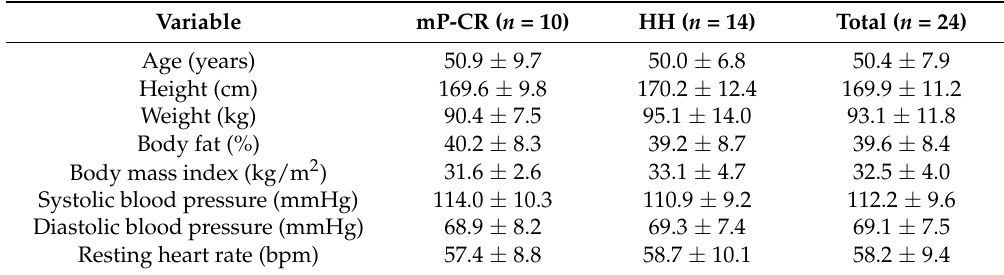
Table 5. Baseline (Week 13) characteristics of study participants for WM (Phase 2).